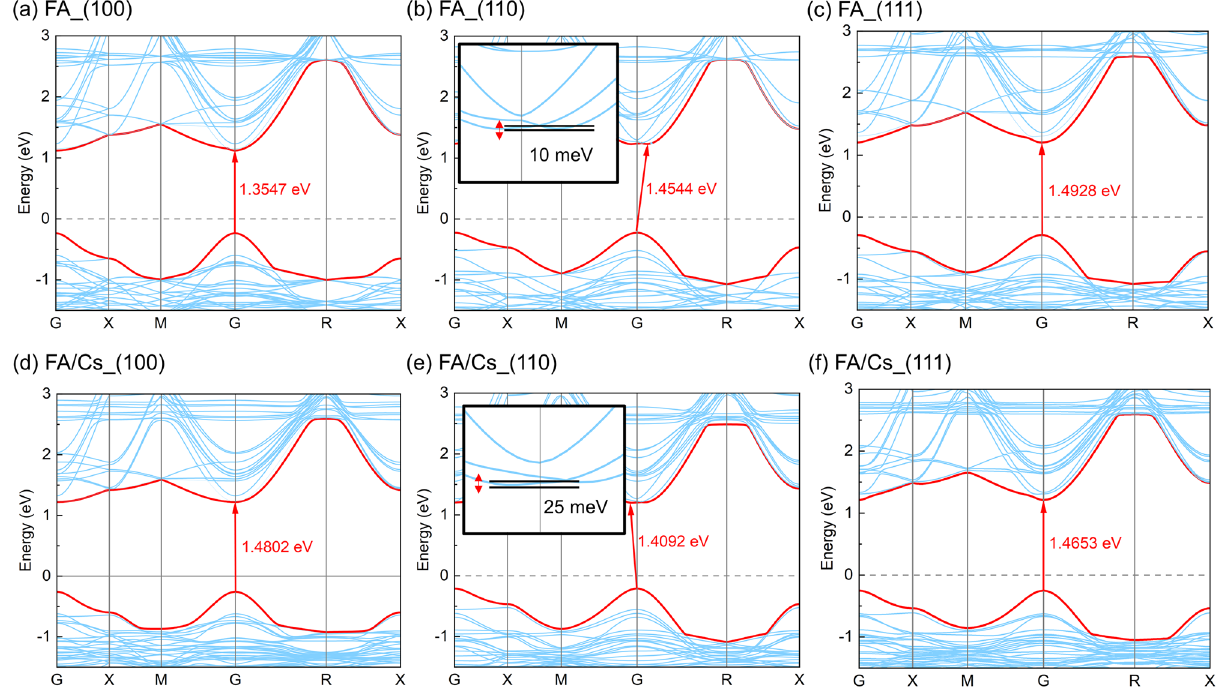
Figure 4. ( a – c ) Band gap of FAPbI 3 with different FA cations orientation: ( a ) (100), ( b ) (110), ( c ) (111); ( d – f ) band gap of